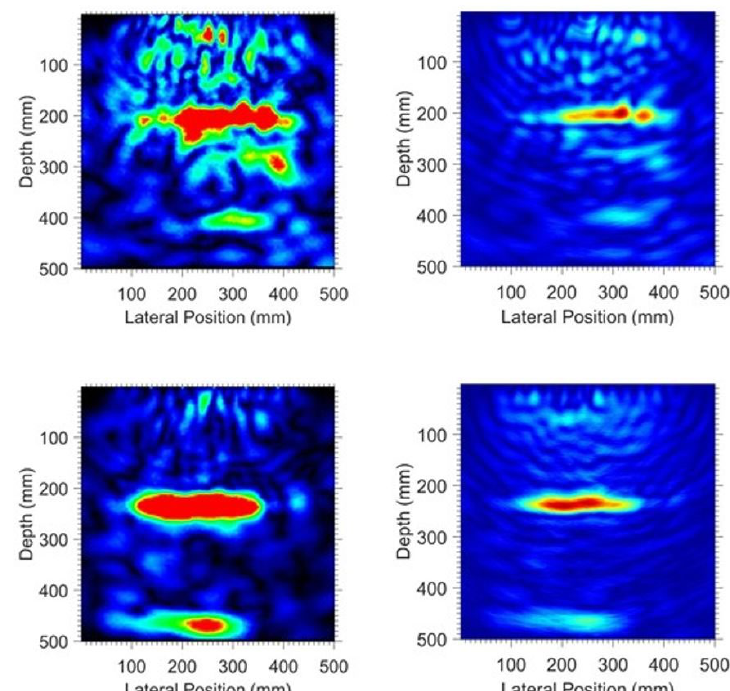
Figure 8. Standard (left) and evaluated (right) images of the other TS’ points (Part 2).